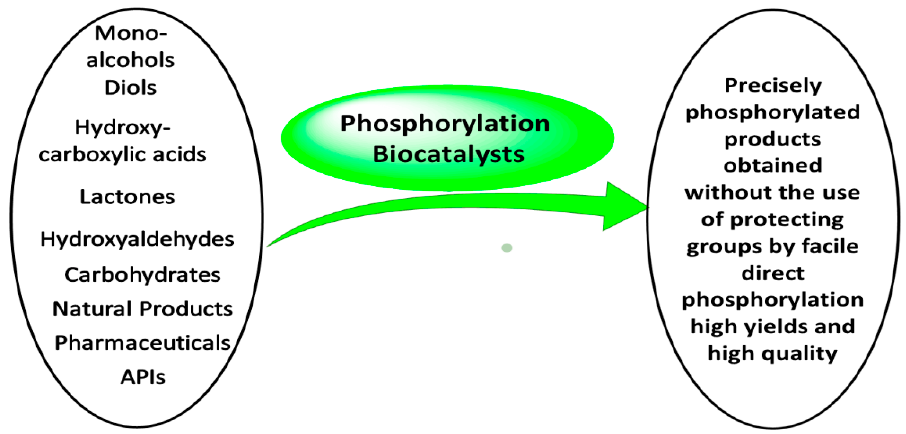
Figure 12. Compound classes of starting materials for preparative phosphorylations using phosphorylation biocatalysts.